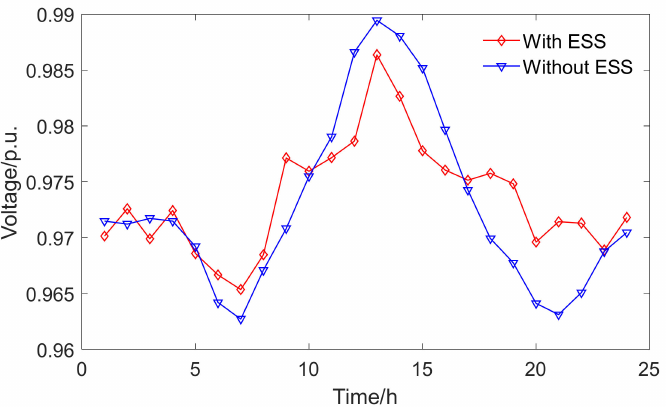
Figure 11. The tenth node voltage.